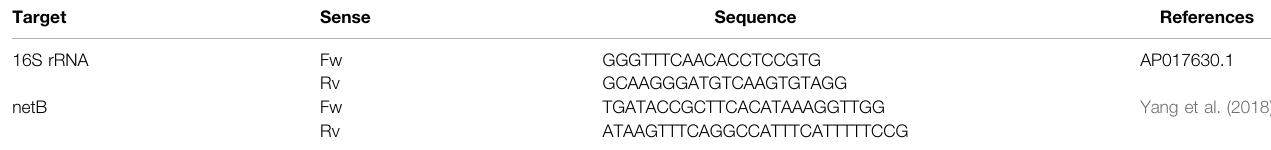
TABLE 2 | Clostridium perfringens qPCR targeted genes and primer sequences used in this study.